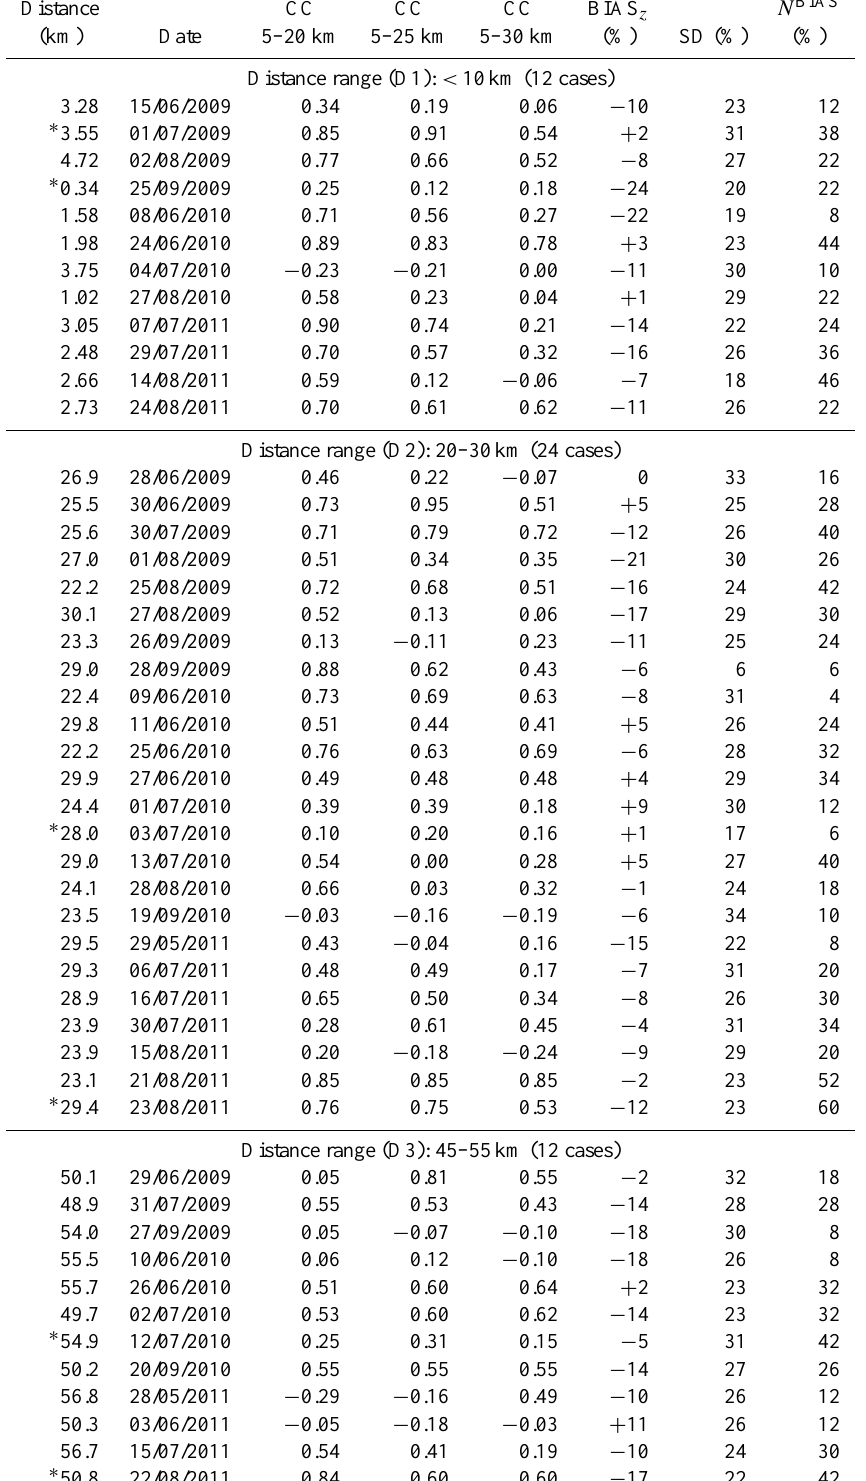
Table 2. Coincident PSC events between MPL-4 and CALIOP measurements at four predominant CALIPSO ground-track distance ranges from Belgrano II station: Correlation coefficient (CC) for three selected height intervals, and the calculated height-averaged BIAS, BIAS z , and their SD together with the number of data points ( N BIAS in %, with respect to the total data points) fulfilling the constraint condition ( − 50% < BIAS < +50%). Particularly analysed cases are marked by